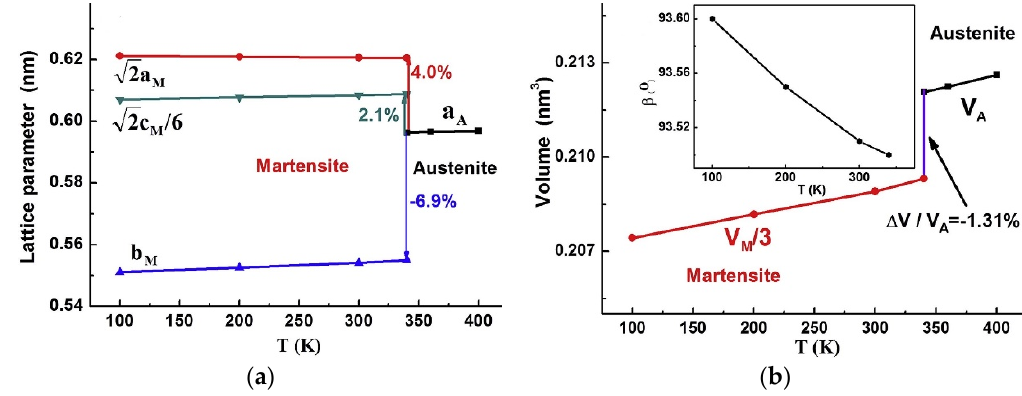
Figure 21. ( a ) Effect of lattice parameters; ( b ) unit cell volume change with respect to temperature [146], with copyright permission from © Elsevier BV .